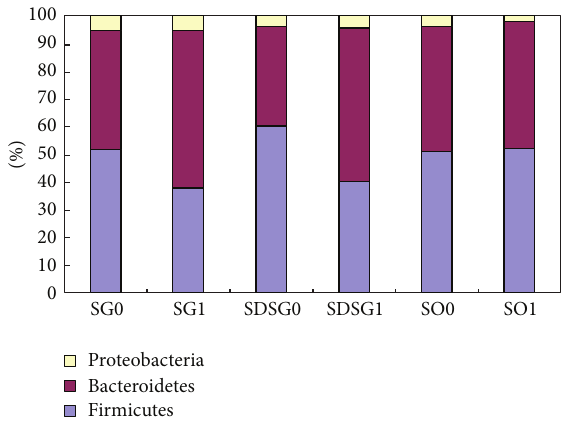
Figure 5: Composition of rat intestinal flora obtained by Sanger sequencing method before sleeve gastrectomy and one month after sleeve gastrectomy. Sleeve gastrectomy group (SG0, SG1), sleeve gastrectomy of SD rats group (SDSG0, SDSG1), and sham-operation group (SO0, SO1).